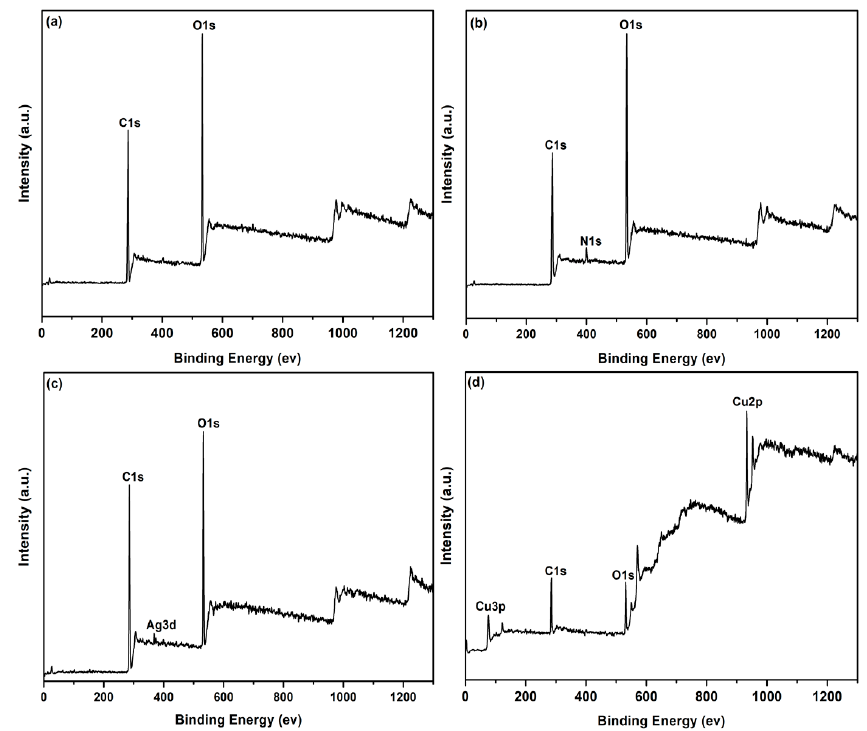
Figure 7. X-ray photoelectron spectroscopy (XPS) spectra of ( a ) original PET fabrics; ( b )PDA/PET fabrics; ( c ) Ag/PDA/PET fabrics; and ( d ) Cu/Ag/PDA/PET fabrics.